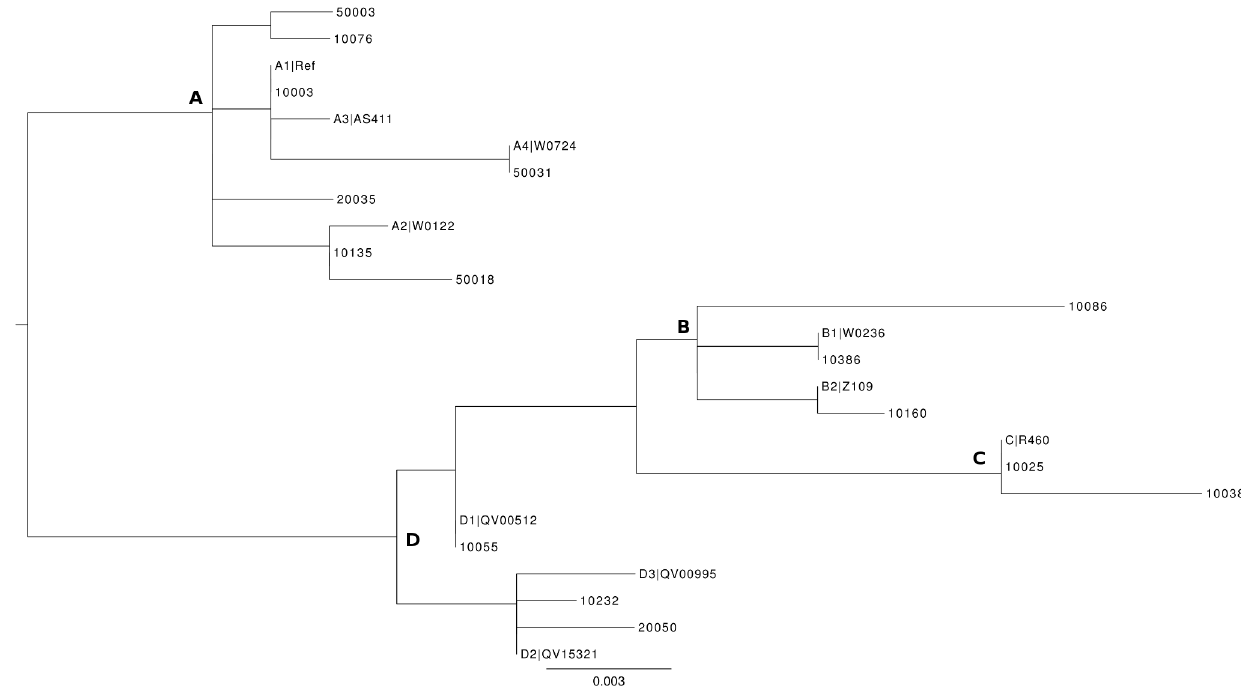
Figure 3. Phylogenetic tree of the HPV16 isolates based on LCR/E6 sequences. Phylogenetic analysis confirmed the presence of the four lineages [4]: A, B, C and D. A maximum likelihood (ML) tree was inferred from an alignment of ten reference sequences and fifteen study sequences of HPV16 LCR-E6 using RAxML HPC v8 [22]. Highly related sequences ( , 0.4 differences) from the study were not included in this figure. Reference sequences were denominated as lineage|strain.